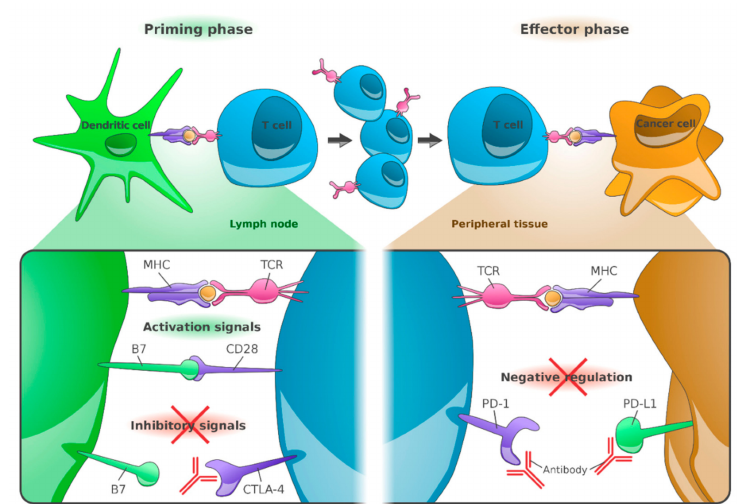
Figure 1. Anti-cytotoxic T-lymphocyte-associated protein 4 (CTLA-4), anti-programmed cell death protein 1 (PD-1) and anti-programmed death ligand 1 (PD-L1) antibodies: Mode of action. Peptides (MHC) on the surface of cancer cells or DCs and recognized by T cells via their T-cell receptor